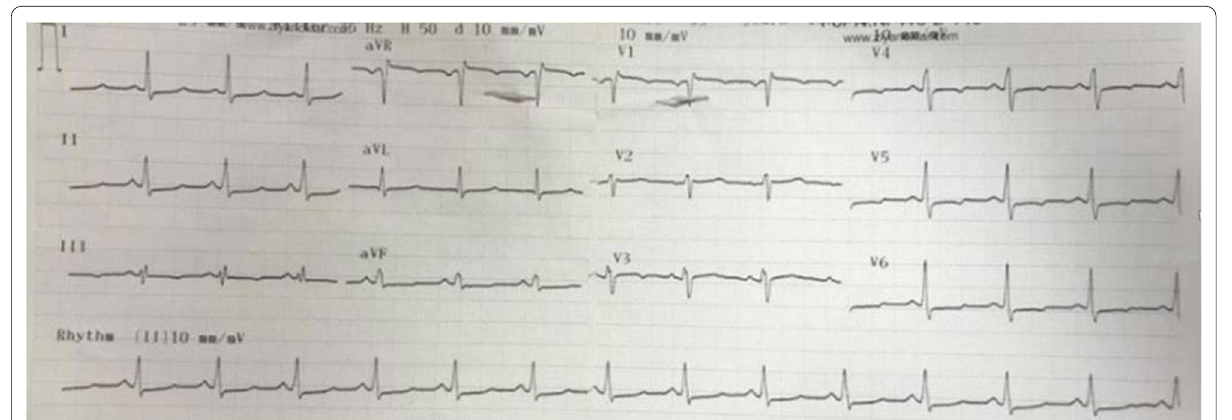
Fig. 2 Preoperative control